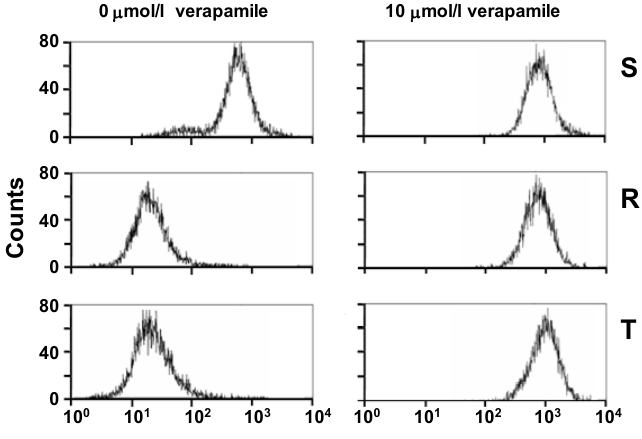
Figure 2. Detection of P-gp function by calcium retention assay in FACS. Data are representative of three independent